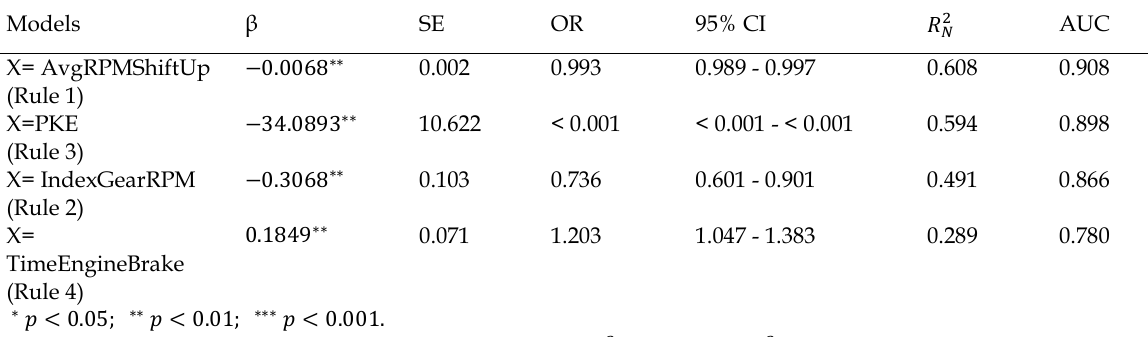
Table 3. Experiment 1: logistic regression models with each of the four indicators associated with the main rules of eco-driving and ranked in descending order of implementation of each driving advice.